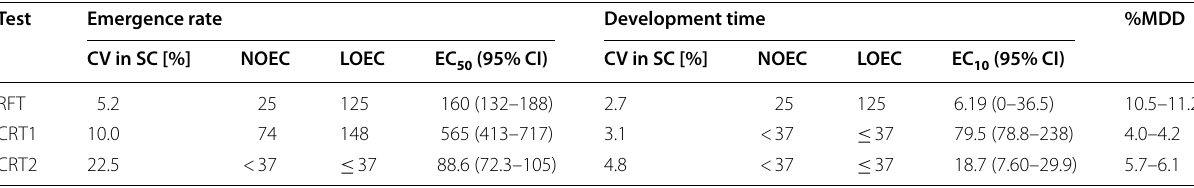
RFT range-finding test, CRT concentration–response test, CV coefficient of variation, SC solvent control, NOEC no-observed-effect concentration, LOEC lowest- observed-effect concentration, ECx X % effective concentration, CI confidence interval, MDD minimum detectable difference